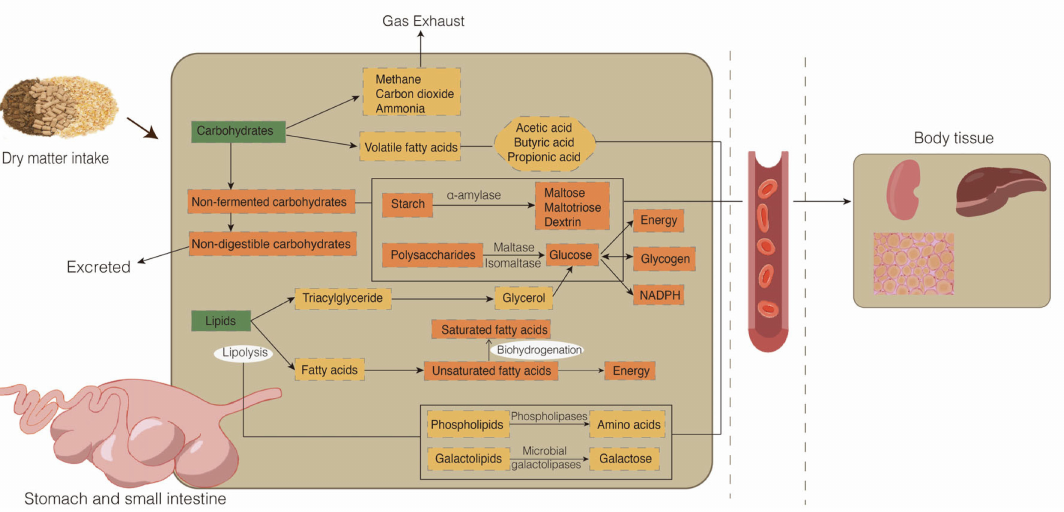
Figure 1. Metabolic processes of glucose and lipid metabolism in ruminants. Green indicates nutrient intake from dry matter; yellow indicates nutrient metabolism in the rumen; orange indicates nutrient metabolism in the small